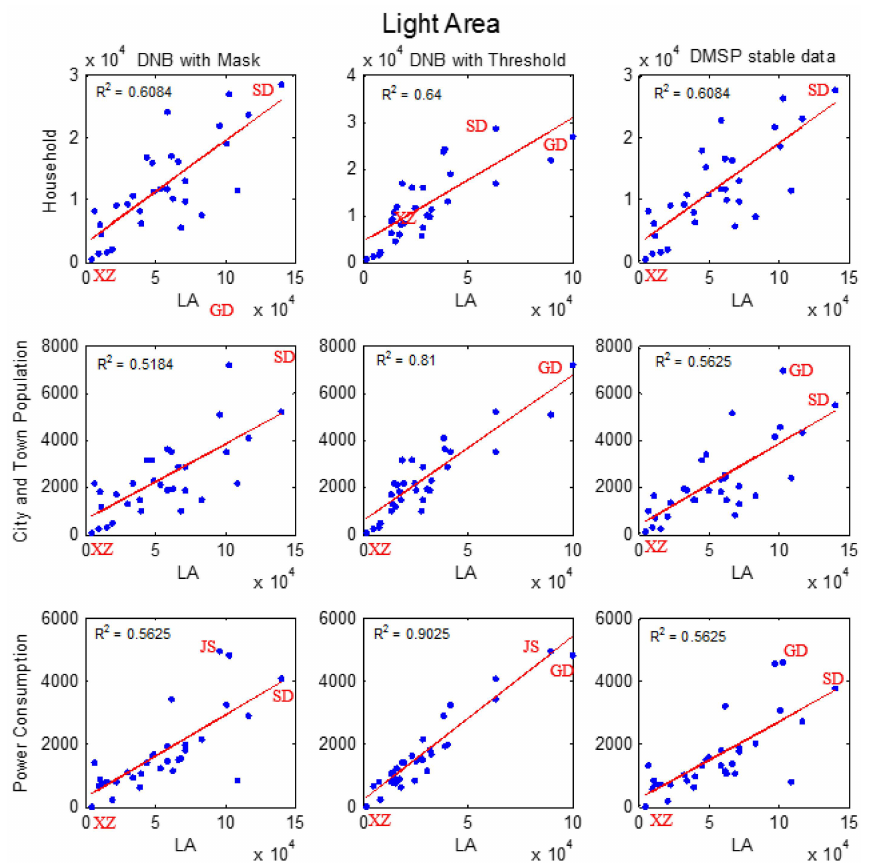
Figure 5. Scatter plots of light areas ( LA ’s) vs. socio-economic parameters (1st row: household; 2nd row: city and town population; 3rd row: power consumption) together with the fitting curve (in red) from regression. LA data used in the 1st, 2nd and 3rd column are derived from DNB composite with NMM and OTM in 2013 and DMSP-OLS stable data in 2012, respectively. Red labels in the panel denote: GD, Guangdong; SD, Shandong; XZ, Xizang; JS,